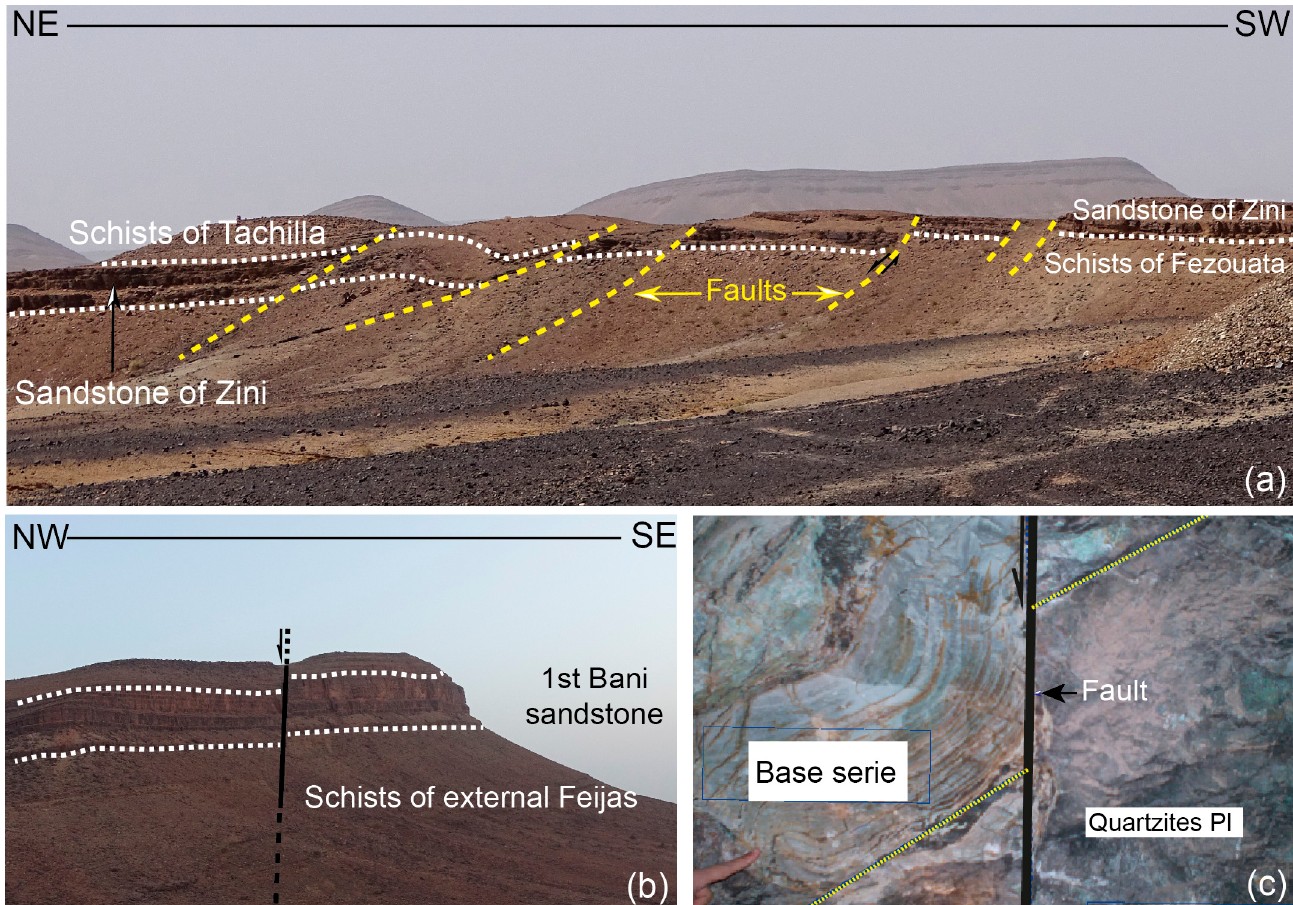
Figure 11. ( a ) Network of normal faults offsetting the Ordovician terrains and hosting the copper veins of Timarighine (Eastern Anti-Atlas). ( b ) Normal fault shifting the sandstone bar of the 1stBani to the west of Tazarine (eastern Anti-Atlas). ( c ) Subsidence of the “Série de base” Formation along a normal fault affecting the Paleoproterozoic (PI) basement in a gallery at the Tazalaght mine (after Tahir et al.[105]).